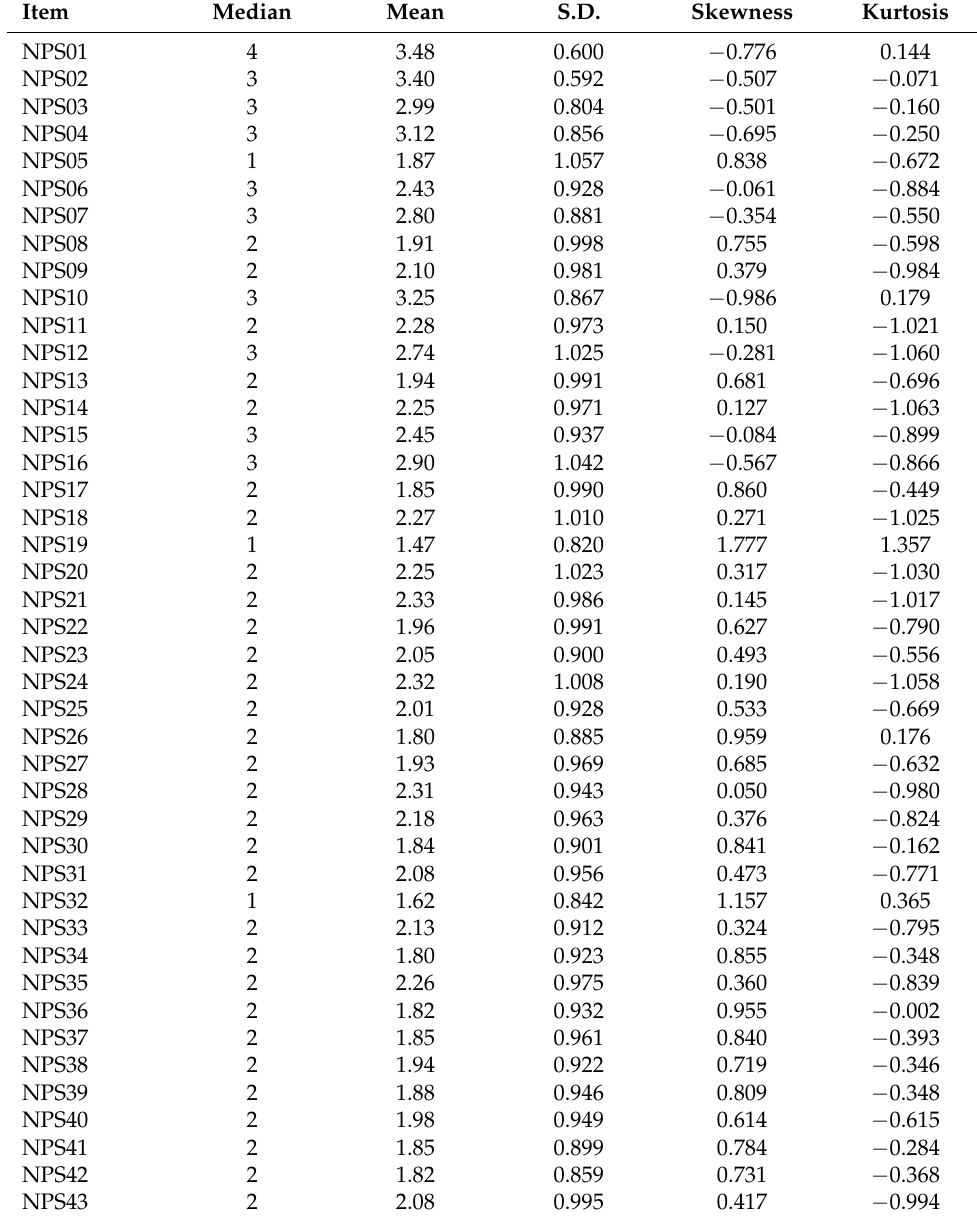
Table 2. Distribution of NPS